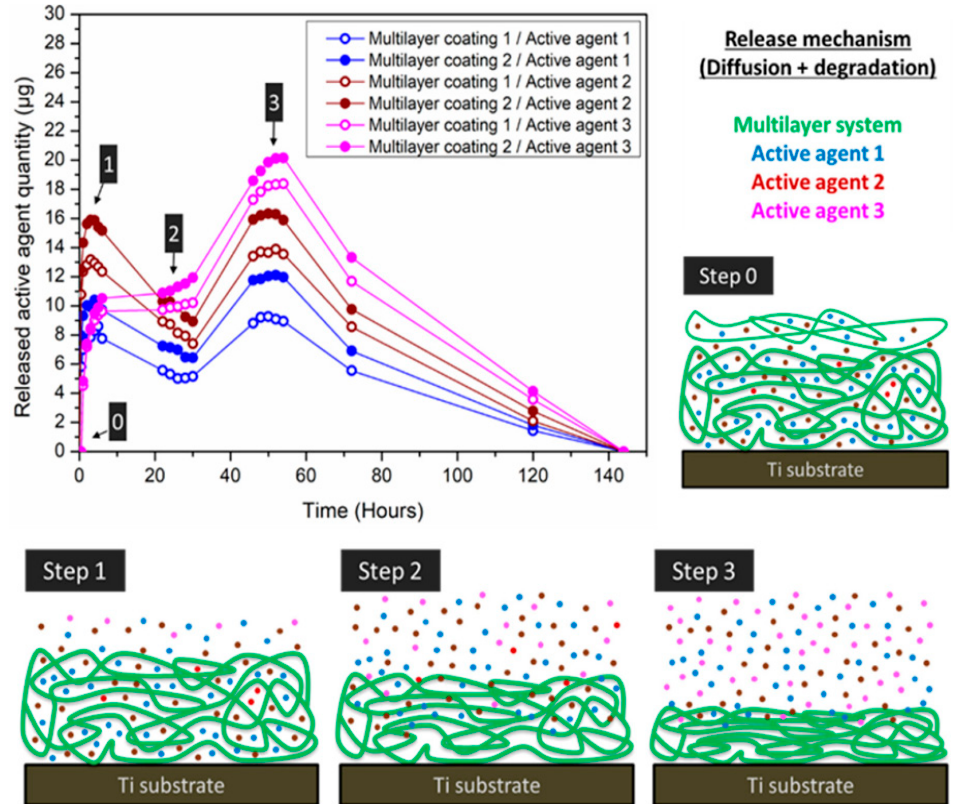
Figure 20. The accumulated controlled release pattern of active agents following 140 h, shown as an instance of a release-based multilayered covering on a Ti substrate. The discharge process via multilayer devices involves drug transport and multilayer breakdown mechanisms. Reprinted with permission from [43]. Copyright 2021 MDPI. Distributed under Creative Commons Attribution-based license (CCBY 4.0.).